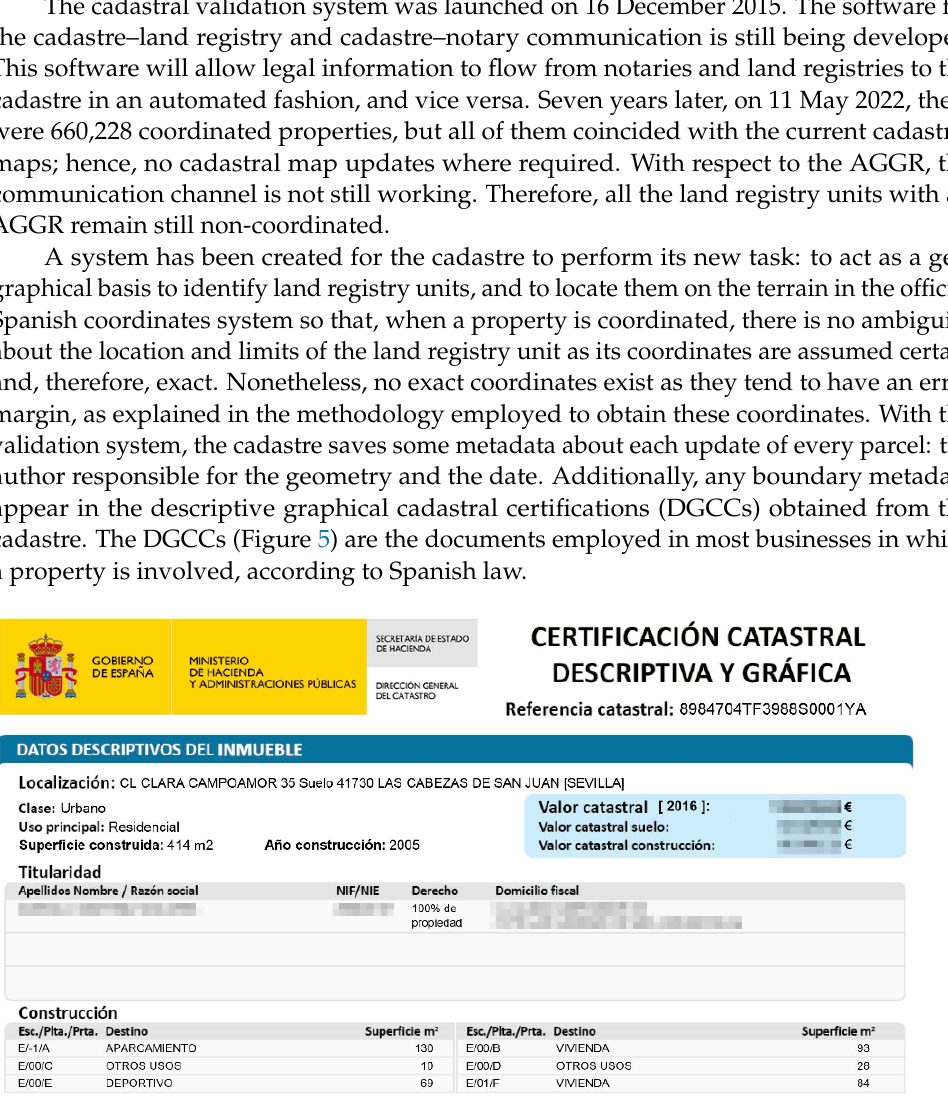
Figure 5. Part of a descriptive geographical certificate of a cadastral parcel. Source: Spanish cadastre.